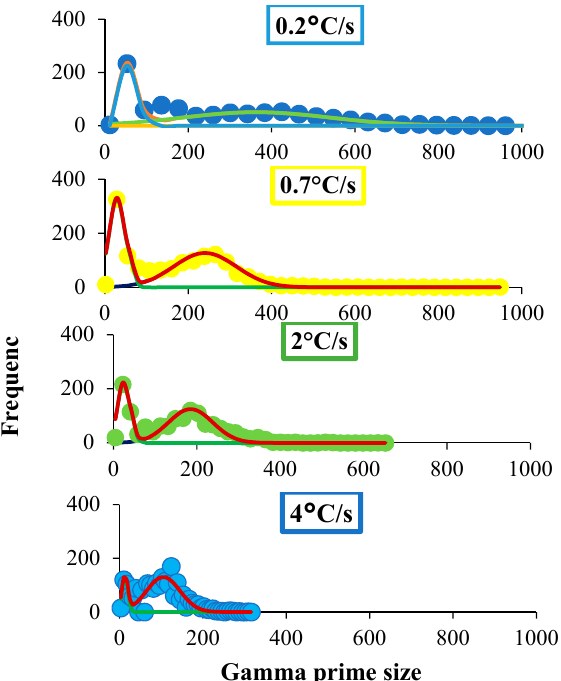
Figure 3. Histograms of γ′ size for each cooling rate under consideration. The continuous curves represent fits to the experimental data using Equation (1).